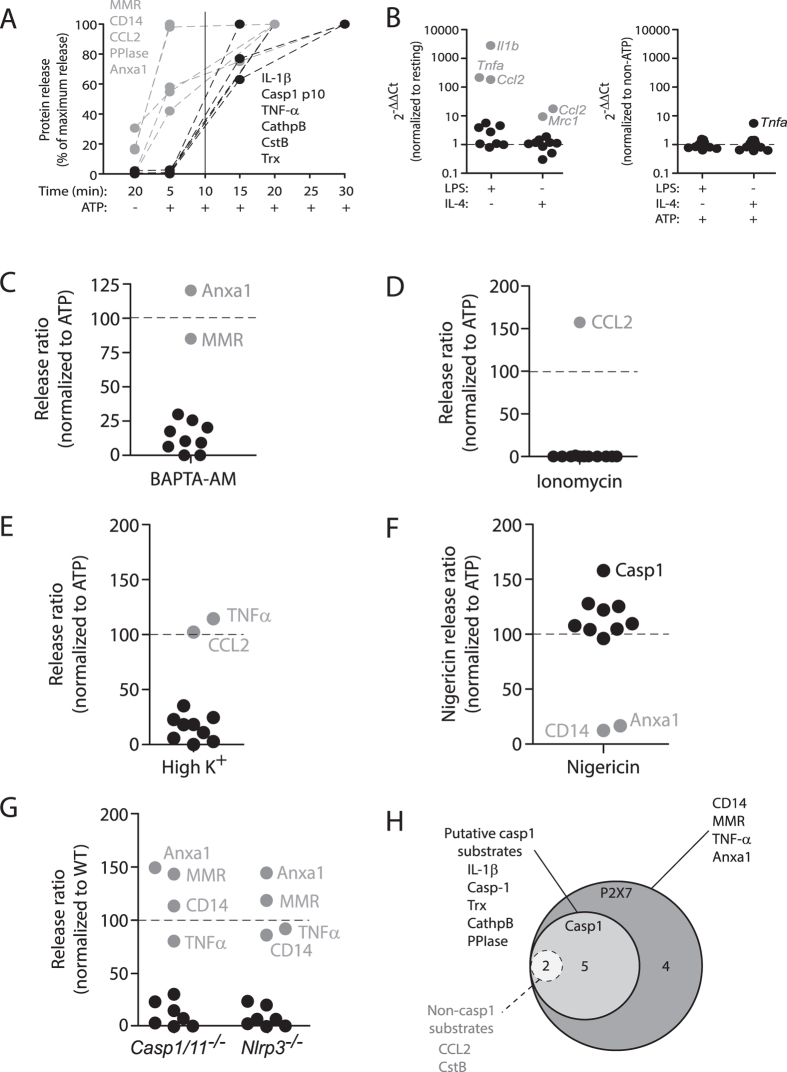
P2X7R secretome do not depend on de novo gene transcription and it is wider than caspase-1 secretome.(A) Quantification of selected P2X7R secretome proteins in cell-free supernatants from BMDMs primed for 4 h with LPS (10 ng/ml for CCL2 and TNF-α or 1 μg/ml for the other), followed by no stimulation (−) or stimulation (+) of P2X7R with ATP (3 mM) for different times as indicated. (B) Relative gene expression for all selected P2X7R secretome proteins determined by quantitative RT-PCR. Left panel show fold change for LPS or IL-4 treatments relative to unprimed (resting) macrophages; Right panel show fold change for LPS + ATP or IL-4 + ATP treatments relative to LPS or IL-4 primed macrophages respectively; relative expression data for each gene is shown in Fig. S4. (C,D) Quantification of selected P2X7R secretome proteins in cell-free supernatants from BMDMs primed as in (A) followed by no stimulation or stimulation for 20 min with ATP (3 mM) (C) or Ionomycin (5 μM) (D); when indicated BMDMs were treated 10 min before and during ATP stimulation with the cell permeable Ca2+-chelator BAPTA-AM (100 μM). Release ratio of ATP in BAPTA-AM treated cells (C) or cells treated with ionomycin (D) is relative to ATP treatment in physiological buffer. (E) Quantification of selected P2X7R secretome proteins in cell-free supernatants from BMDMs primed and stimulated as in normal (2 mM) or high (145 mM) K+ buffer. Release ratio of ATP in high K+ buffer treated cells is relative to ATP treatment in physiological buffer. (F) Relative release ratio of selected P2X7R-dependent secretome proteins induced by nigericin (5 μM) treatment relative to ATP treatment. (G) Relative release ratio of selected P2X7R-dependent secretome proteins in Casp1/11−/− or Nlrp3−/− macrophages relative to wild type macrophages. (H) Venn diagram showing the relation between proteins secreted by macrophages upon P2X7R activation and their dependence on caspase-1 activation. Two proteins are dependent on caspase-1, but are not direct substrates of caspase-1 (dotted line circle). Western blots used for densitometry and ELISAs are shown in Fig. S3, S5, S6A and S7.